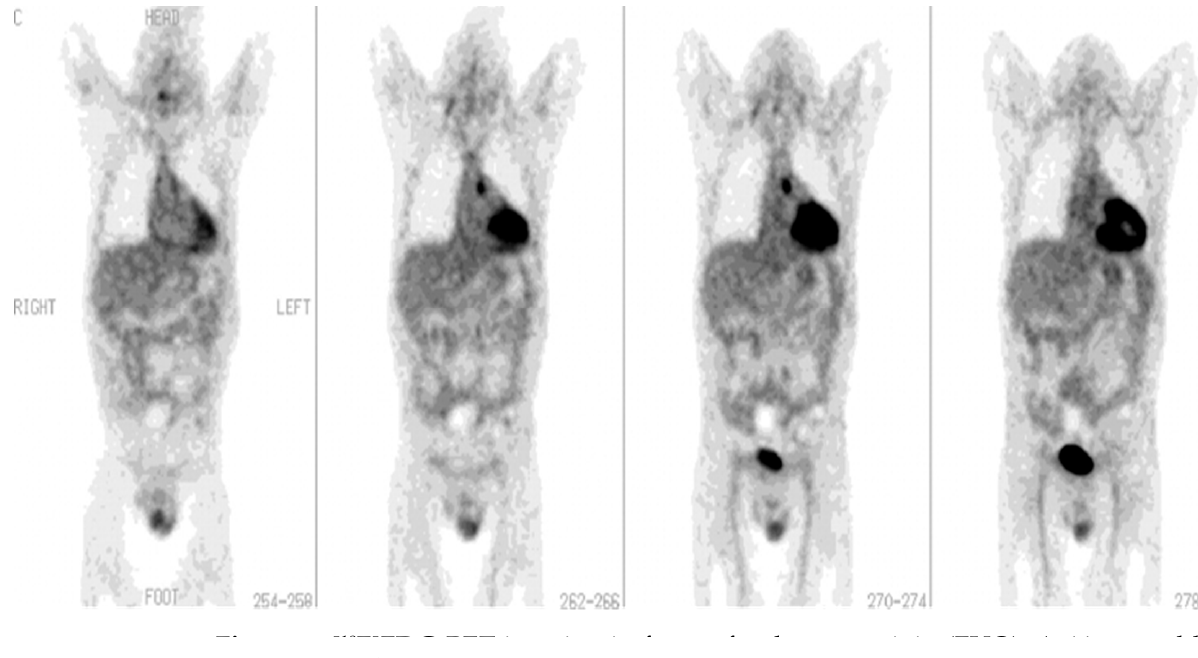
Figure 2. [ 18 F]FDG-PET imaging in fever of unknown origin (FUO). A 44-year-old man after heart transplant presented with fever of unknown origin and inconclusive radiologic studies, including CT. Coronal PET images demonstrate a focus of increased [ 18 F]FDG activity in the aortopulmonary window that represents the source of infection. The patient completely recovered following drainage of the infected site in the mediastinum (with permission from [10]).